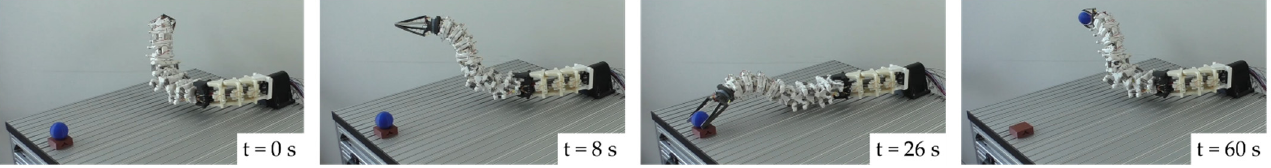
Figure 10. Movement sequence for pivoting, tilting, and gripping a sphere. The duration of the entire sequence was 60 s.